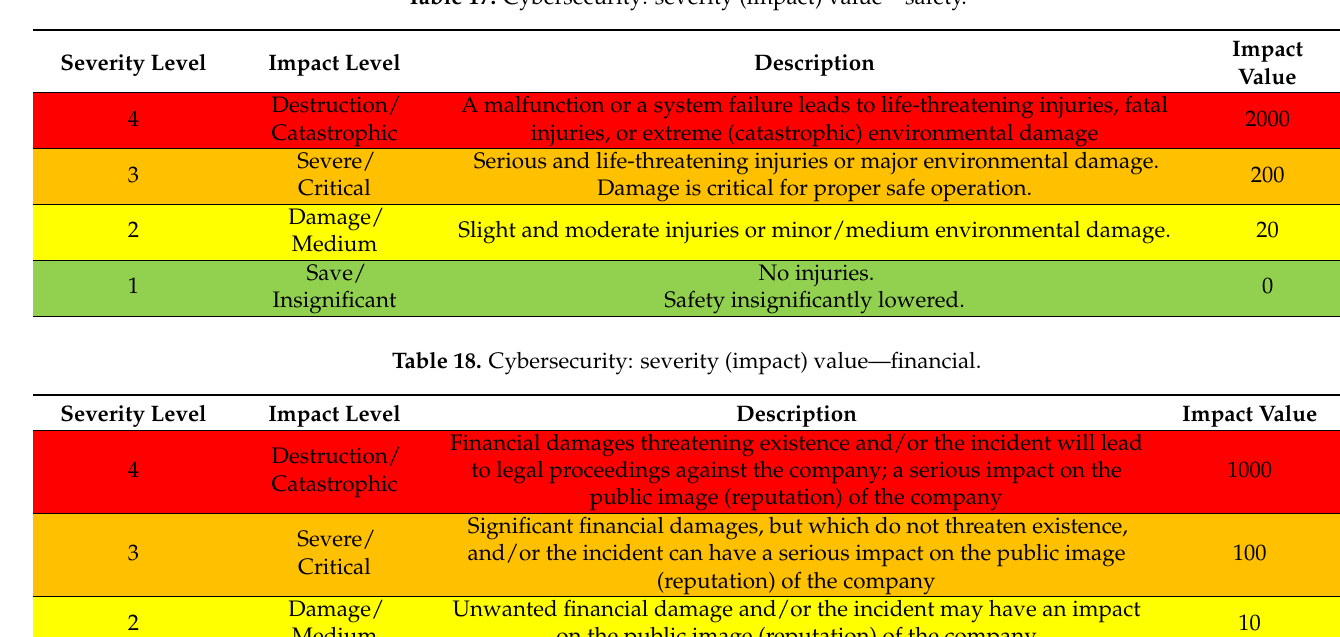
Table 17. Cybersecurity: severity (impact) value—safety.